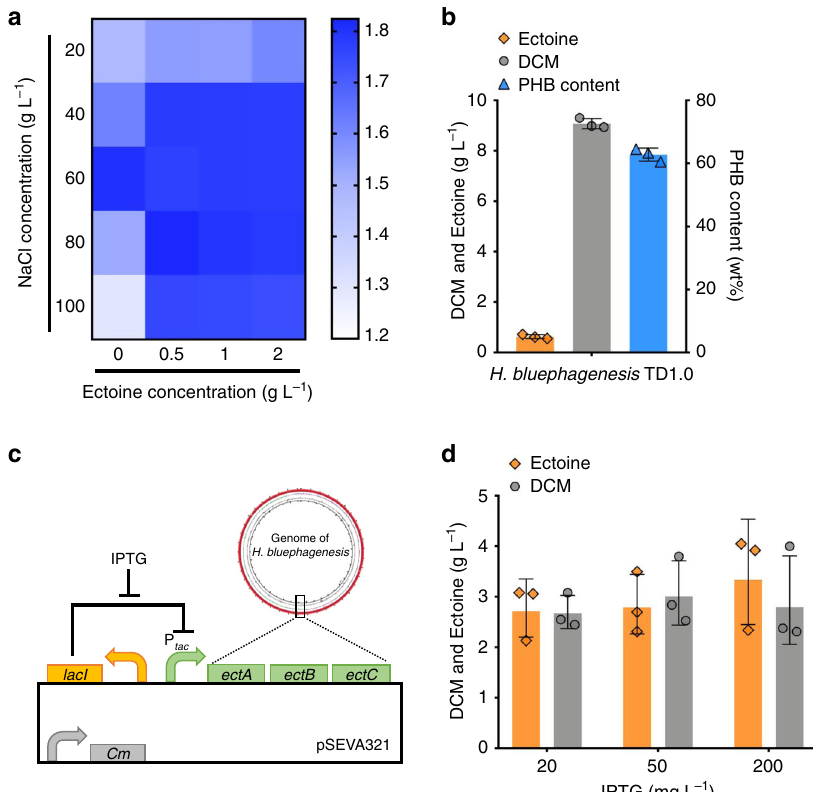
Fig. 2 Identi fi cation of the ectoine biosynthesis pathway of H. bluephagenesis TD1.0. a Heatmap of cell growth in a MM medium supplemented with 10 g L − 1 glucose in the presence of different NaCl (vertical axis) and ectoine concentrations (horizontal axis), repectively, cultured in a 96-well plate for 24 h. The color shade variation in blue indicates gradient value of optical density under 600 nm (OD 600 ). b Conceptional proof of ectoine production by H. bluephagenesis TD1.0 cultured in a 60MMG (60 g L − 1 NaCl) medium used in previous studies. c Cloning the ectABC ectoine operon from H. bluephagenesis TD1.0 to a plasmid-based expression system pSEVA321, under the control of the tac promoter (P tac ) inducible by IPTG. d Ectoine production by E. coli DH5 α harboring an ectABC expression module in the presence of 100 mM sodium aspartate and three IPTG concentrations in a LB medium supplemented with 10 g L − 1 glucose, respectively. Data are presented as mean values, error bars represent standard deviations (SD); n = 3 biologically independent samples. Source data underlying ( a ), ( b ), and ( d ) are provided as a Source Data fi